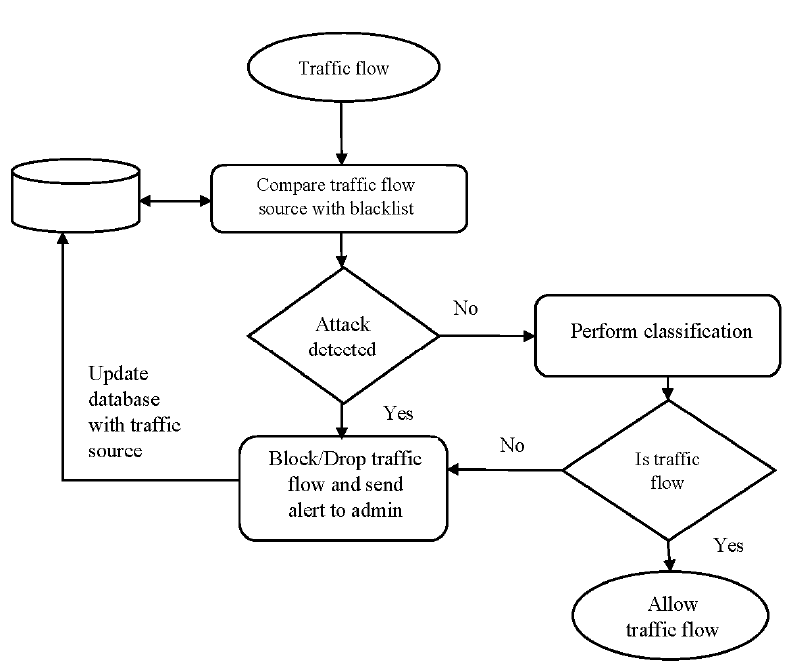
Figure 3. Flow chart of the operation of the proposed framework.